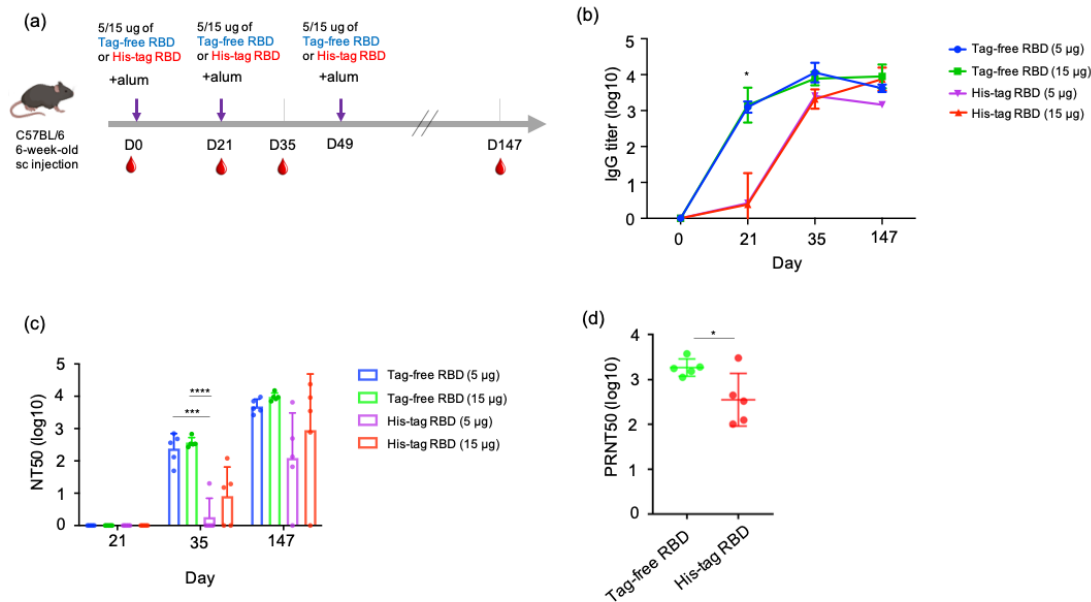
Figure 3. SARS-CoV-2 IgG antibody titers and neutralizing antibodies derived from vaccination with tag-free RBD and His-tag RBD. Design of mouse immunization study ( a ). Antigen-specific IgG titers of mouse serum collected at day 0, 21, 35, or 147 were detected by ELISA ( b ). Neutralization titers of mouse serum collected at day 21, 35, or 147 were detected by pseudotyped virus NT50 assay ( c ). Neutralizing activity of mouse serum collected at day 147 against the Delta variant was determined by live SARS-CoV-2 neutralizing assay ( d ). Data are presented as mean ± SD and results were compared by the Student’s test or ANOVA followed by Dunnett’s test. p < 0.5 was considered sta-